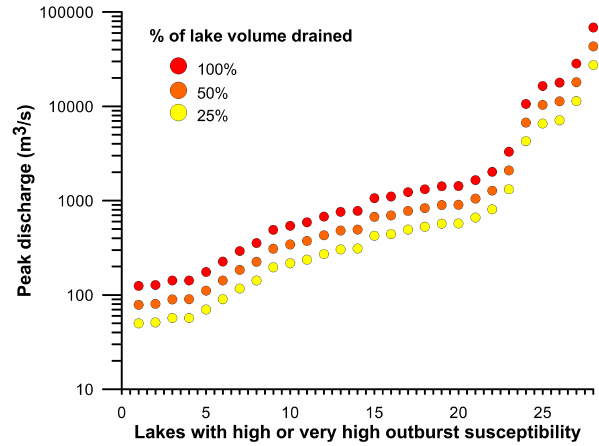
Figure 12. Potential peak discharge of GLOFs from lakes with high or very high outburst susceptibility in the Baker